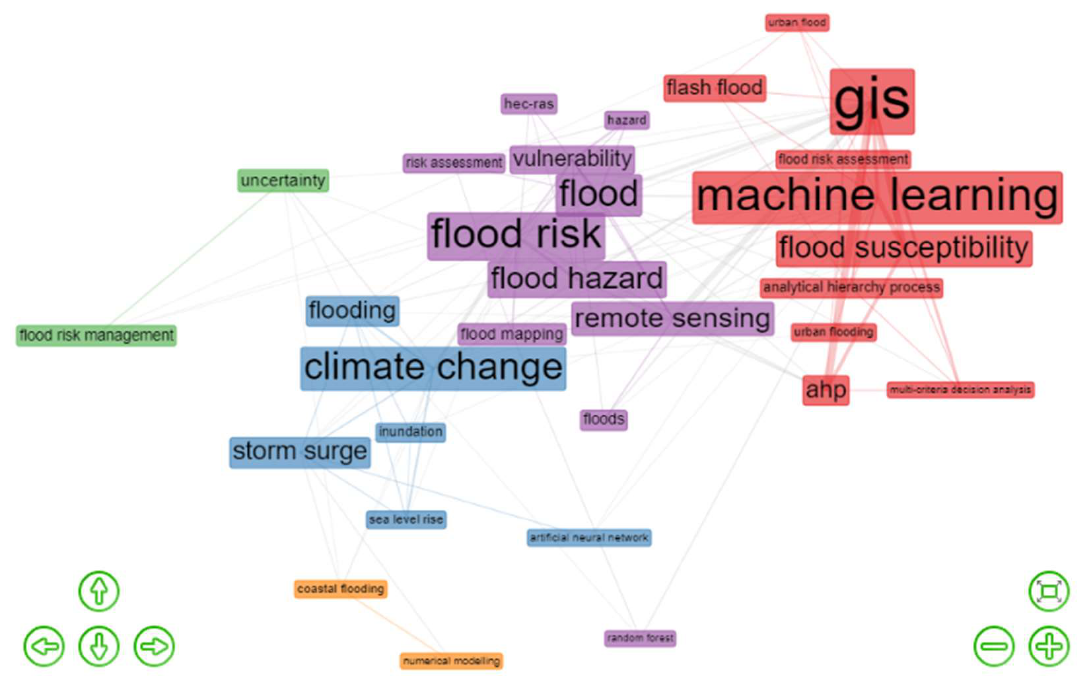
Figure 7. Author’s Keywords Co-occurrence Network.